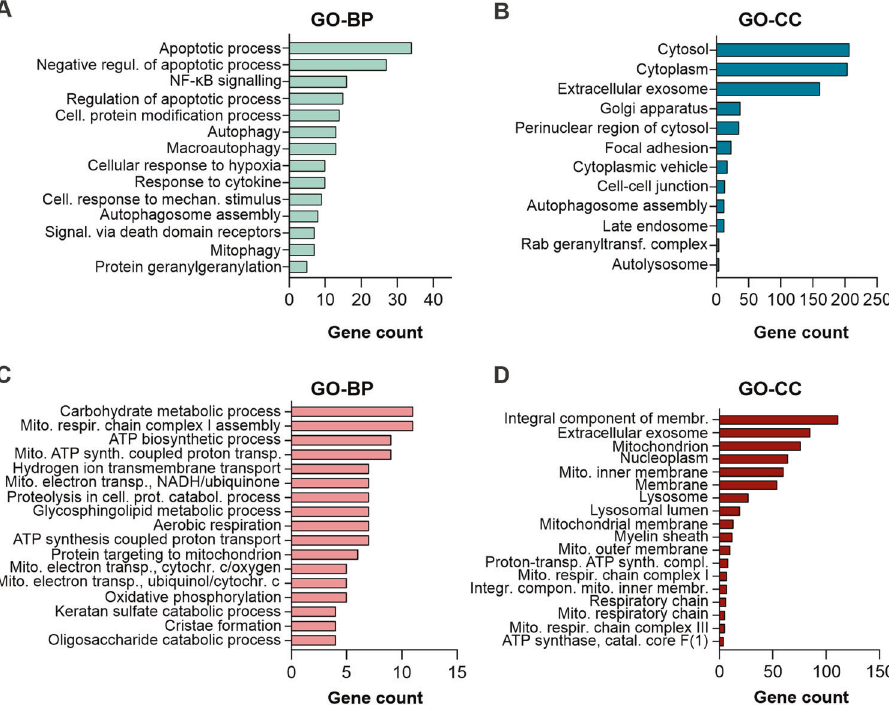
Fig. 4 Proteomics enrichment analysis for ba fi lomycin A1. Bar chart showing the number of proteins upregulated ( A , B ) or downregulated ( C , D ) by ba fi lomycin A1 that cluster for Gene Ontology (GO) terms for Biological Process (BP) and Cellular Component (CC) with a log p -value of p < 10 − 3